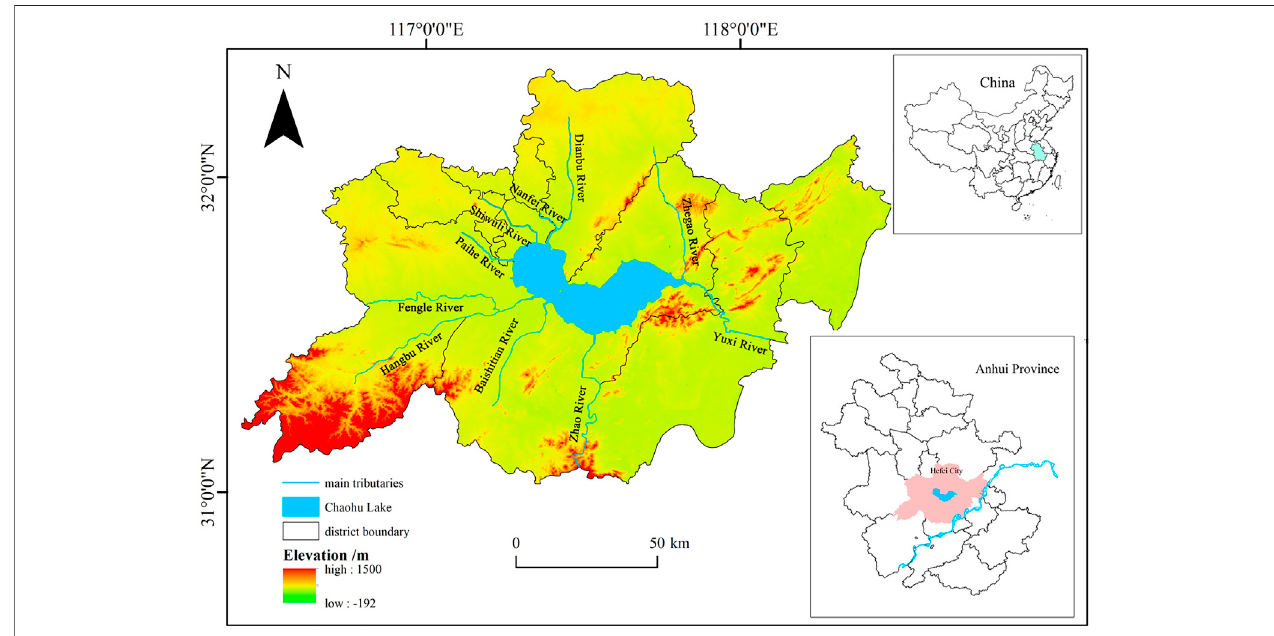
FIGURE 1 | Location and distribution of Chaohu Lake.